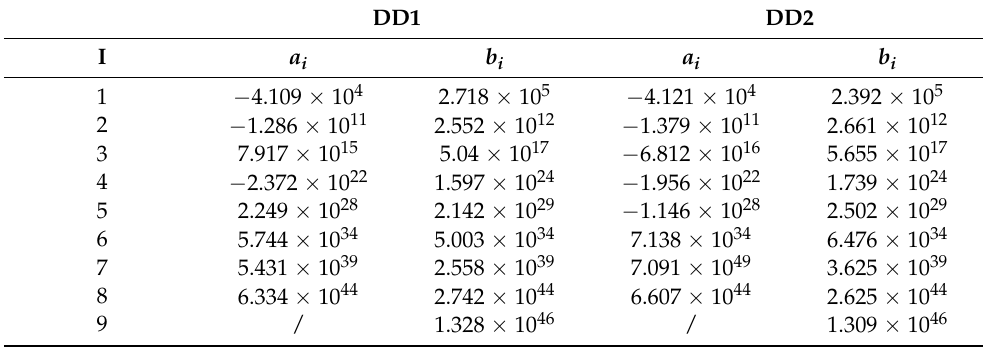
Table 5. Transfer function coefficients for the DD1 and DD2 current transfer